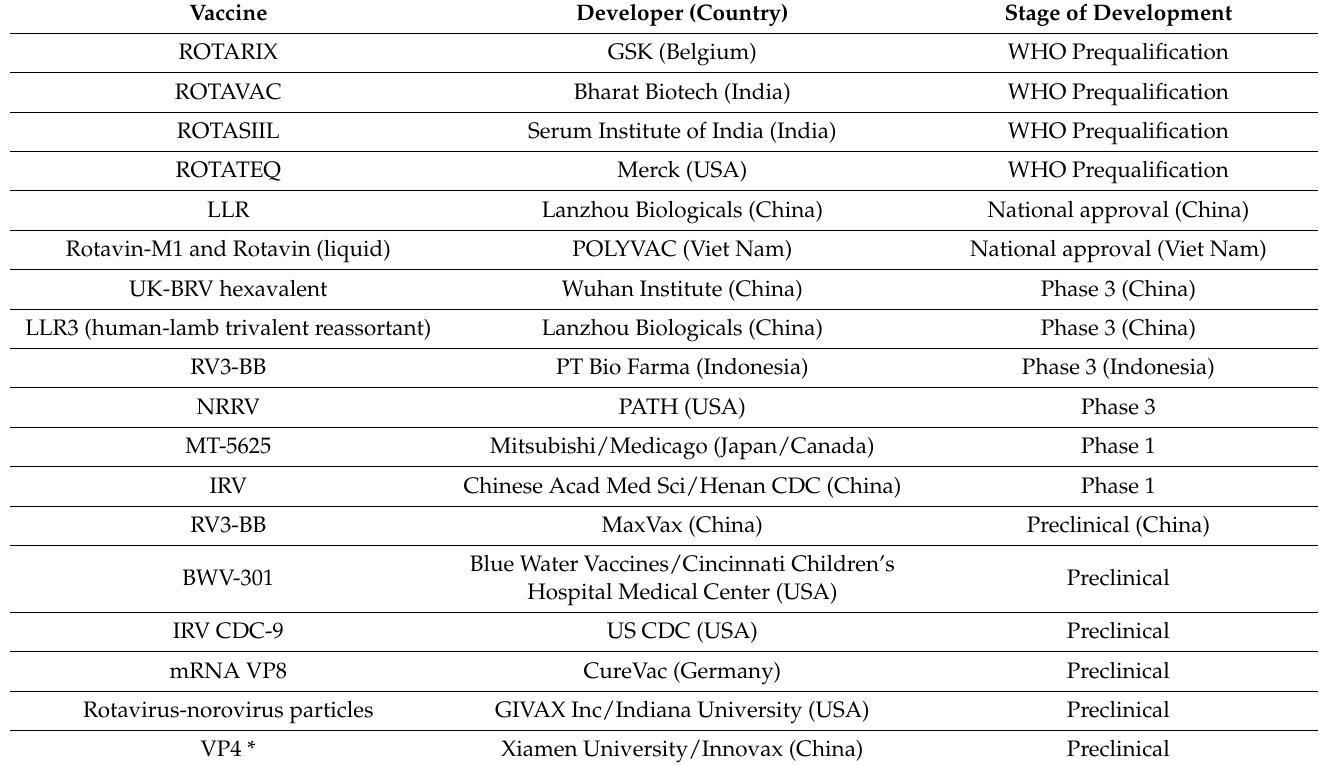
Table 1. Rotavirus vaccines licensed for global use, in clinical development, and selected vaccines in pre-clinical